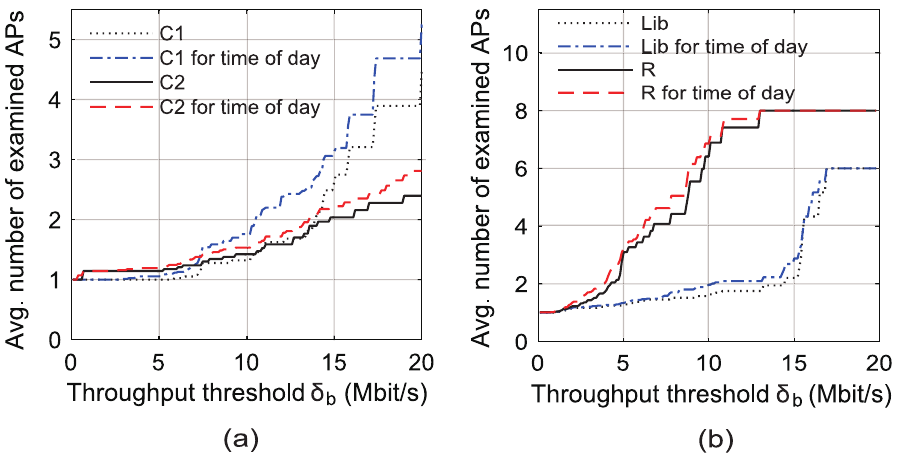
Fig 12. Number of examined APs vs. required throughput, δ